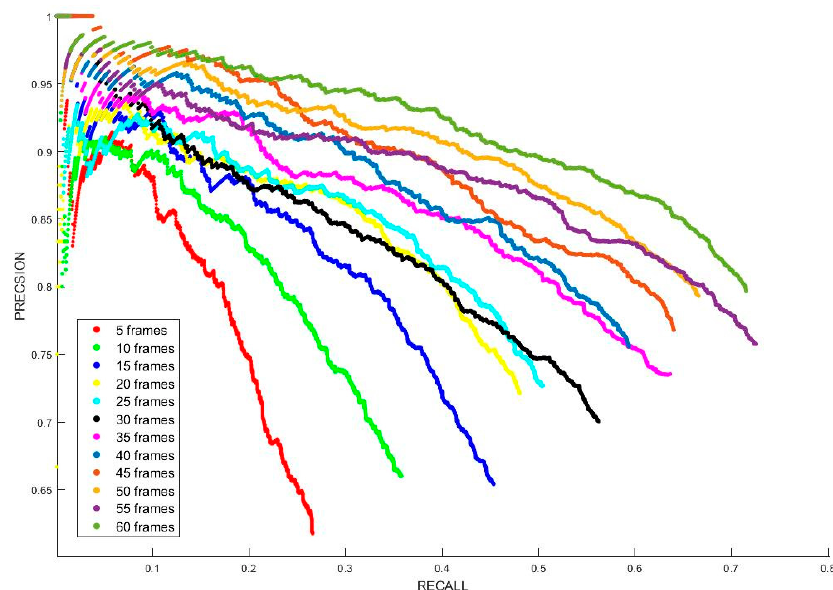
Figure 3. Average precision curve for the Faster R-CNN model trained on 5–60 frames.